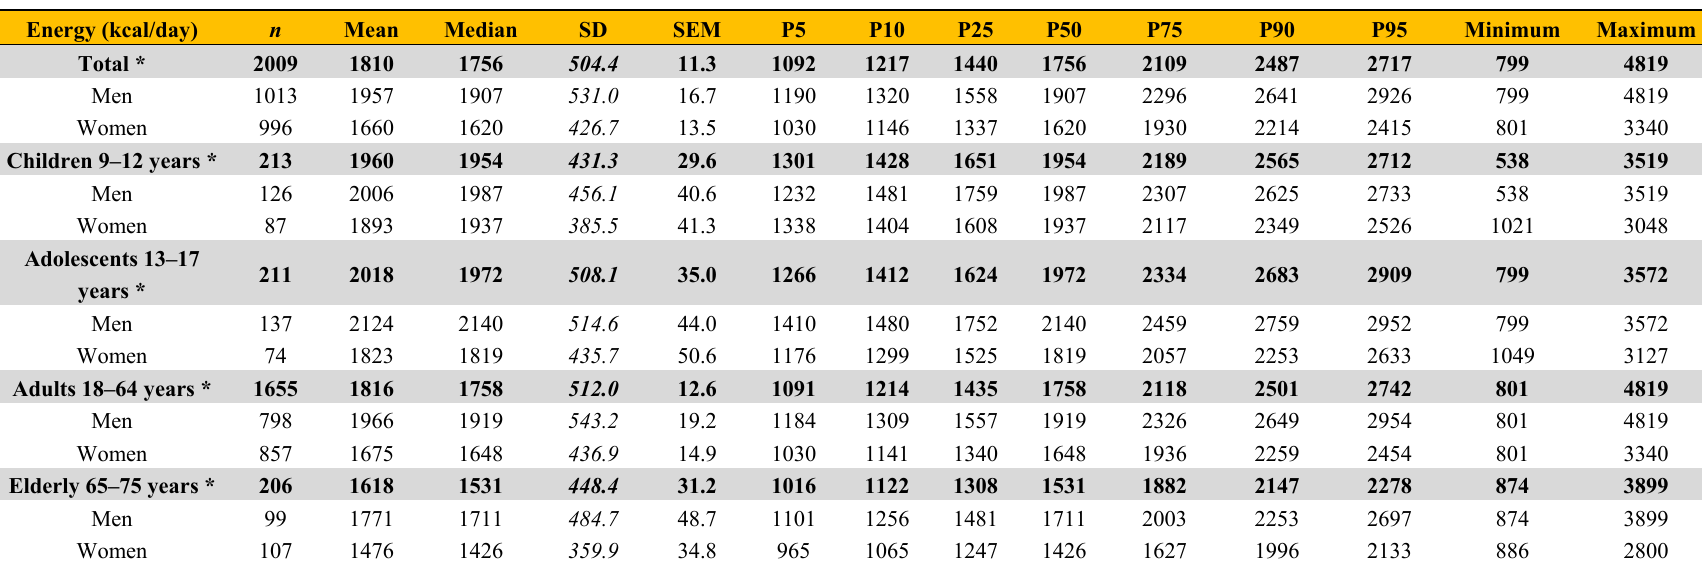
Table 2. Energy distribution (kcal/day; MJ/day), by age group and sex, in the ANIBES survey of the Spanish population aged 9–75 years. Energy